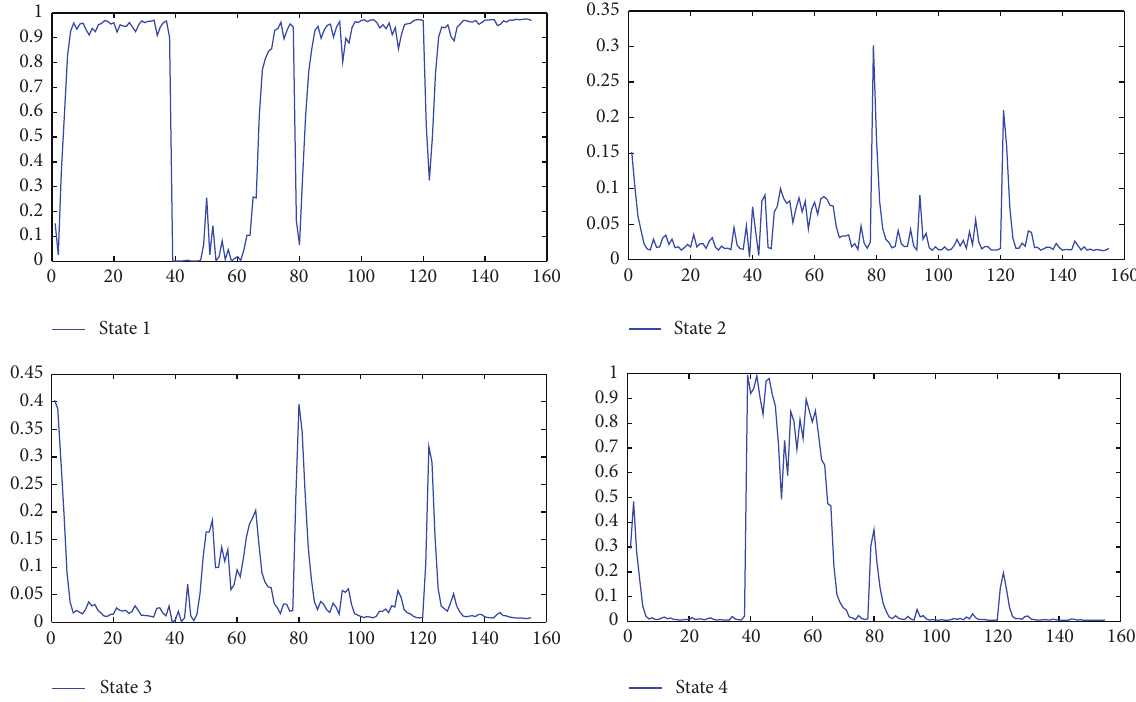
Figure 11: Filtered probabilities P (𝑆 𝑡 = 𝑘 | 𝜓 𝑡 ) for 𝑡 ∈ Λ , 𝑘 ∈ {1,2,3,4} .